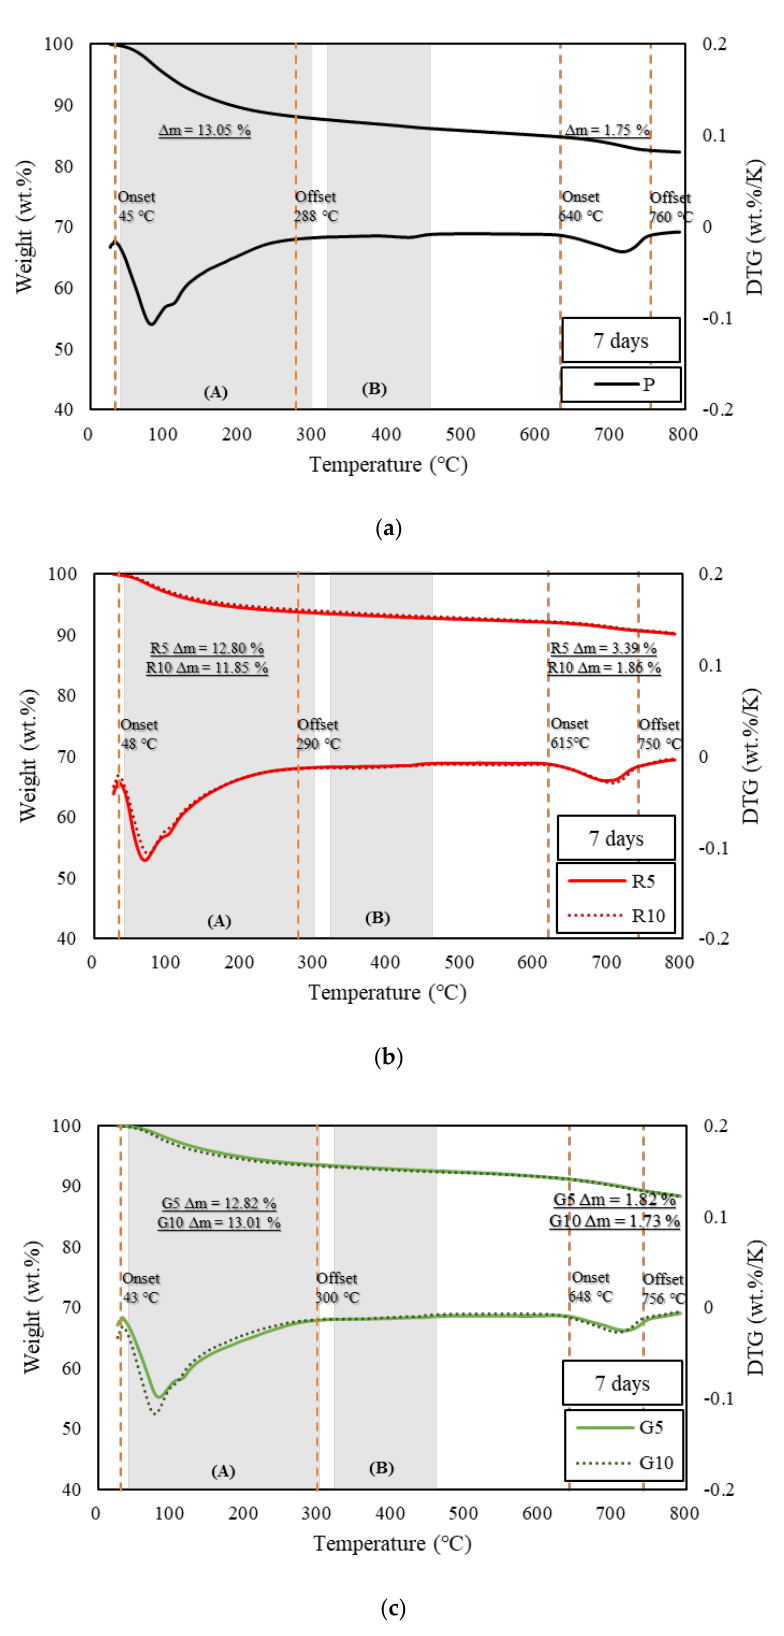
Figure 3. TGA of samples at three days. ( a ) TGA results of specimen P at the age of three days, ( b ) TGA results of specimens R5 and R10 at the age of three days, and ( c ) TGA results of specimens G5 and G10 at the age of three days.